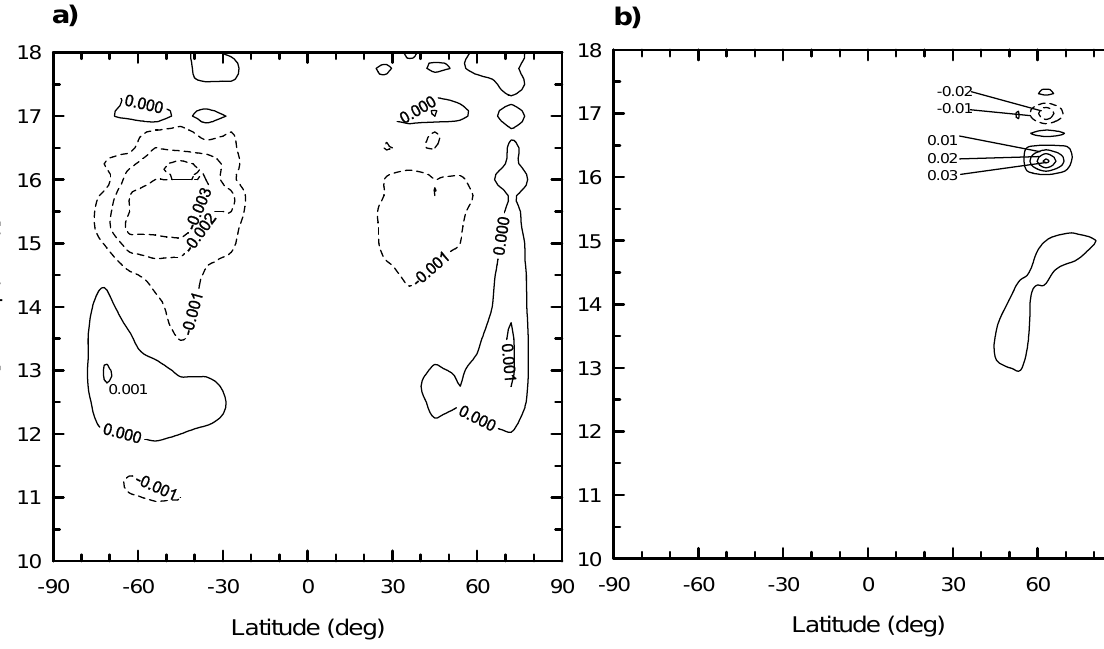
cooling ( 1h r < 0). Also similar to those estimations, the ϕ -dependence of 1h r reflects roughly that of δT (Figs. 4– 8). Namely, the larger δT corresponds to the stronger cool- ing rate. The profiles δT ( z) of the 2-, 5-, 10-, and 16-day waves in the UMLT region (Figs. 5–8) show maximums in the upper mesosphere and lower thermosphere. Those result